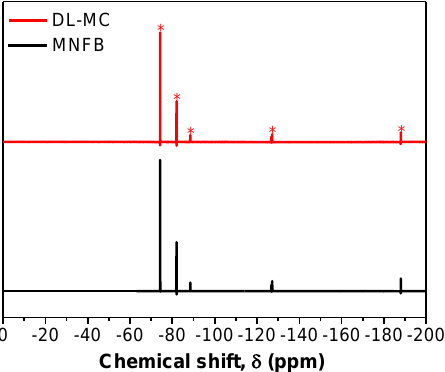
Figure 6. 19 F − NMR spectra of non-flammable liquid and